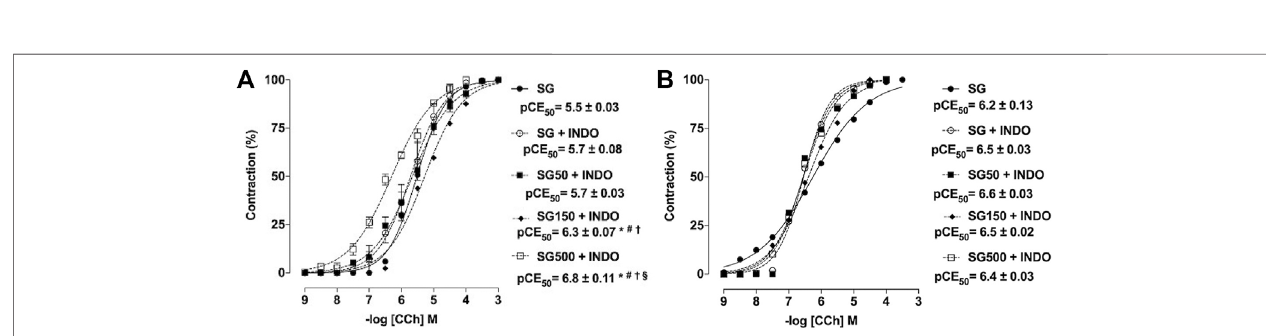
FIGURE 3 | Contractile effect of CCh in the absence SG ( C ) and presence of indomethacin in SG50 (fx1), SG50 ( ■ ) and SG150 (fx2) SG500 groups (fx3) in rat tracheainthepresence (A) andabsenceofepithelium (B) .ThesymbolsandverticalbarsrepresentthemeanandS.E.M.,respectively(n=5).One-wayANOVAfollowed byBonferroni ’ spost-test.* p < 0.05(SG vs. SG150+INDOandSG500+INDO), # p < 0.05(SG+INDO vs. SG150+INDOandSG500+INDO), † p < 0.05(SG50+INDO vs. SG150 + INDO and SG500 + INDO) and § p < 0.05 (SG150 + INDO vs. SG500 + INDO). INDO = indomethacin. Healthy saline group = SG. Healthy group supplemented with S. platensis at 50, 150 and 500 mg/kg = SG50, SG150 and SG500, respectively.